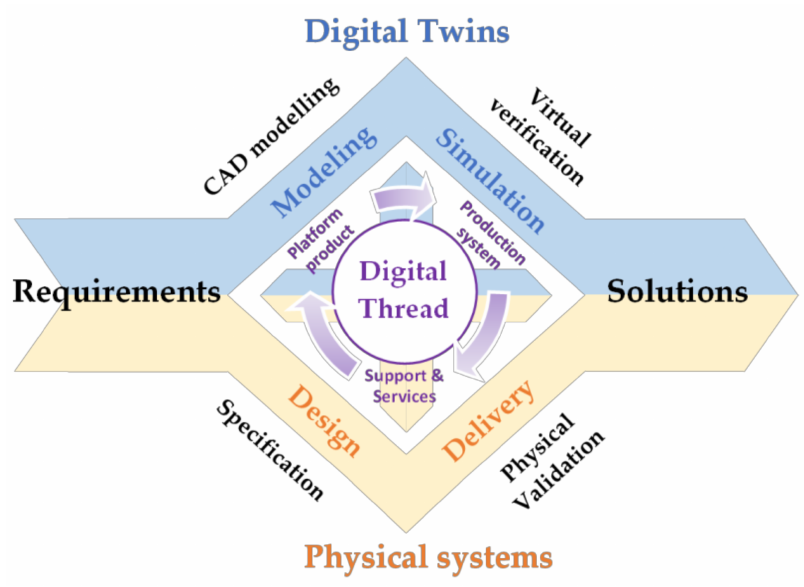
Figure 6. Proposed MBSE “Diamond” modified from Boeing: approved for public release (RROI